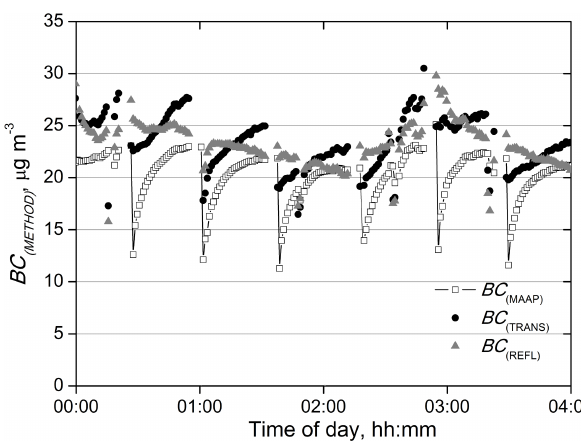
Fig. 2. Comparison of BC measured with the MAAP by multi-angle photometry BC MAAP , transmission BC TRANS and reflectance BC REFL methods during a high concentration episode in Gual Pa- hari, India, 12 August